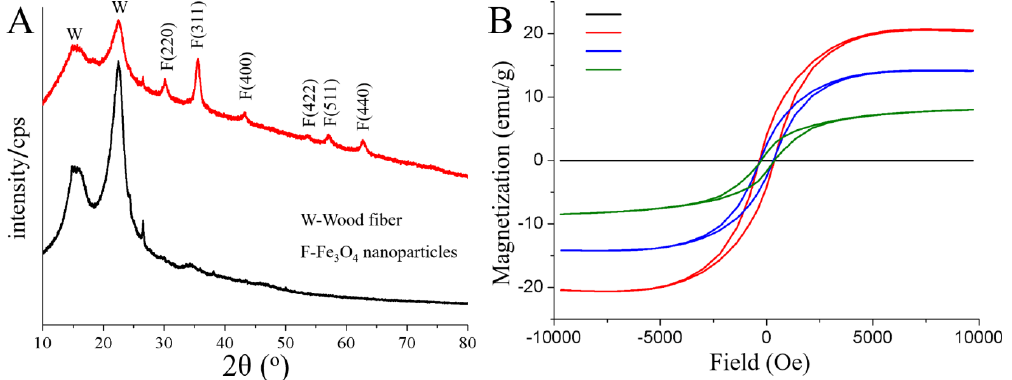
Figure 3. ( A ) XRD patterns of the untreated (black) and treated (red) wood fibers. ( B ) VSM curves of the untreated wood fibers (black), and magnetic wood fibers with impregnation time of 24 h (green), 48 h (blue), and 72 h (red), respectively.